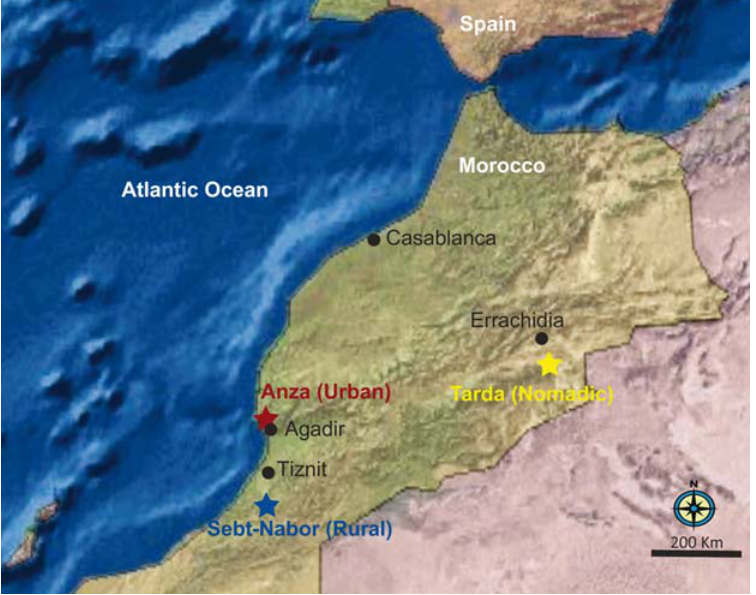
Figure 1. Geographic locations of sampled Amazighs groups in Morocco. A total of 52 peripheral blood samples were collected: 20 urban samples from the town of Anza (Latitude: 29.367 u , Longitude: 2 9.633 u ), 15 rural samples from the rural village of Sebt-Nabor (Latitude: 31.450 u , Longitude: 2 9.650 u ), and 17 nomadic samples from the Sahara desert in eastern Morocco (Latitude: 31.809 u , Longitude 2 4.603 u ). Subsets of these were used in the gene expression profiling, genotyping and methylation profiling as described in Table S5.